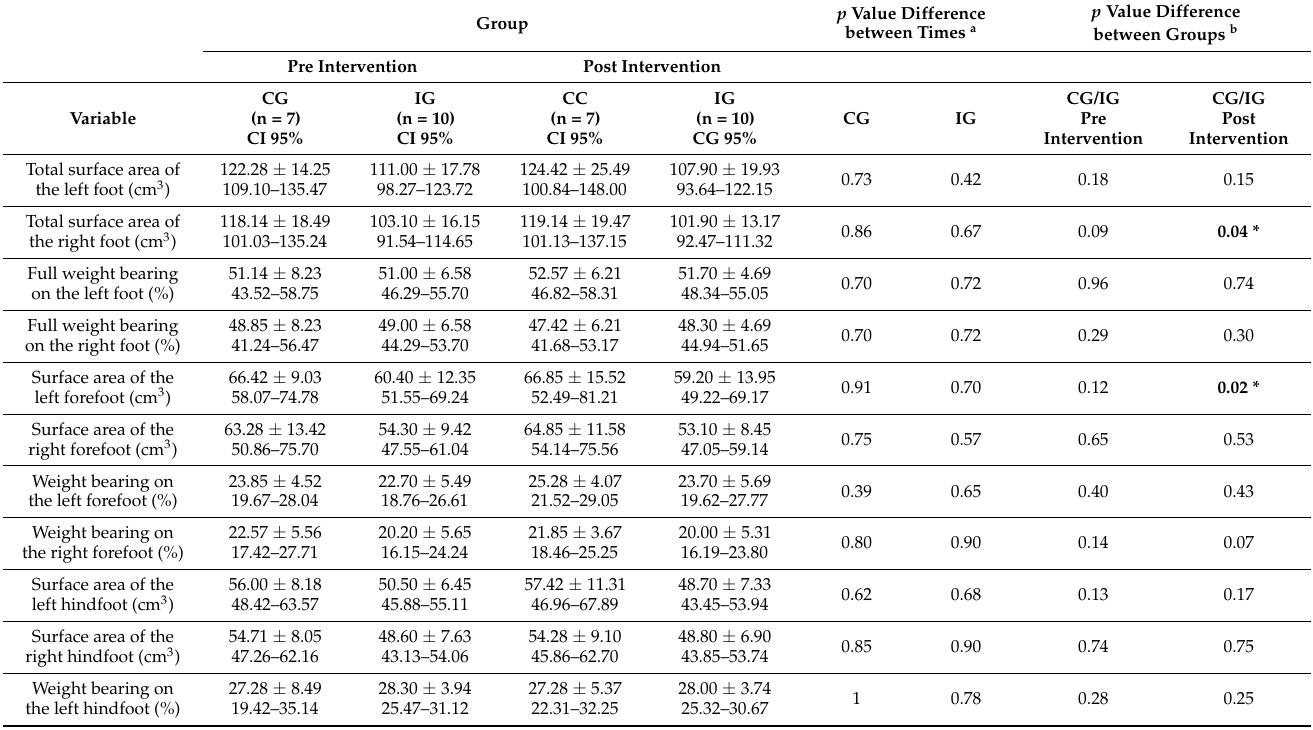
Table 4. Mean values, standard deviation and confidence interval in the comparison of GC and IG for distribution variables and plantar